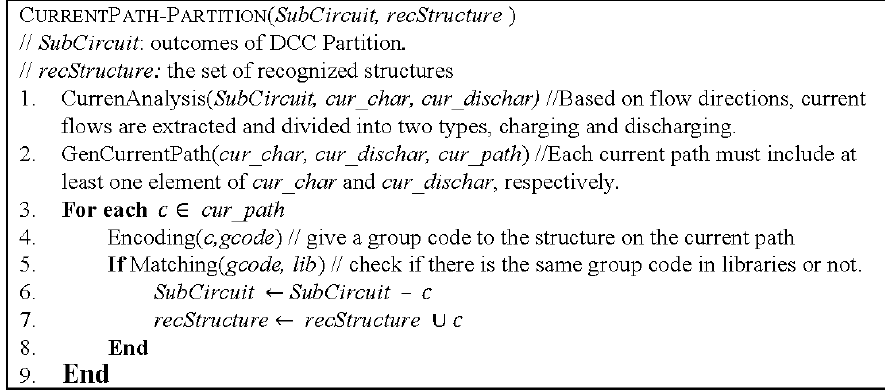
Figure 8. Pseudocode of current path-based partitioning.